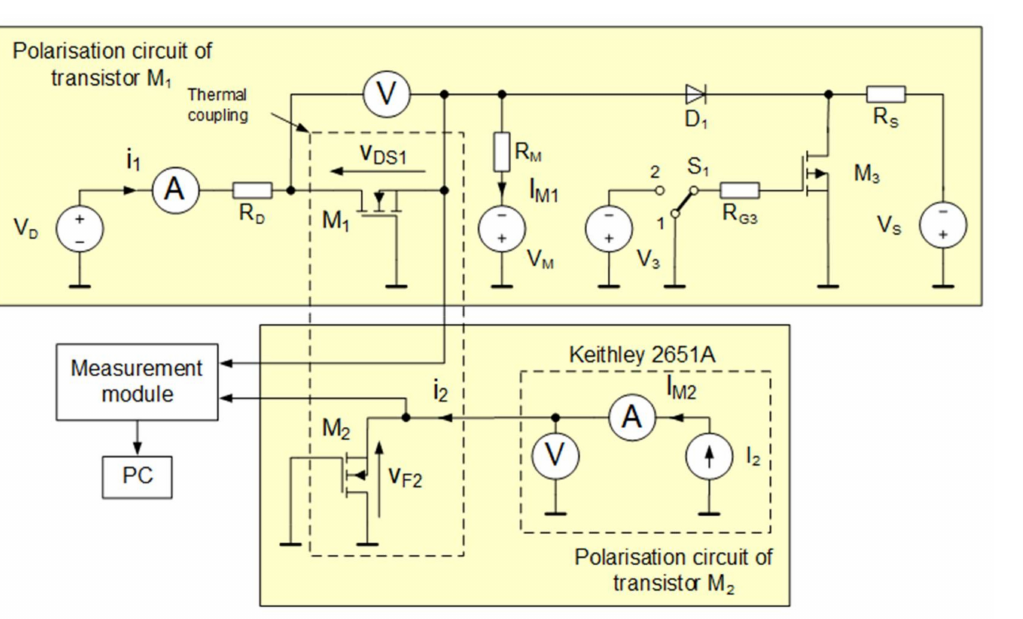
Figure 1. Diagram of the measurement